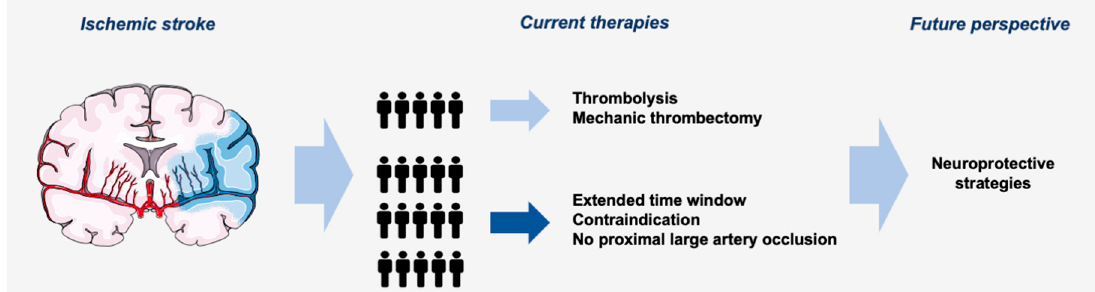
Figure 1. Current ischemic stroke treatment and its limitations.